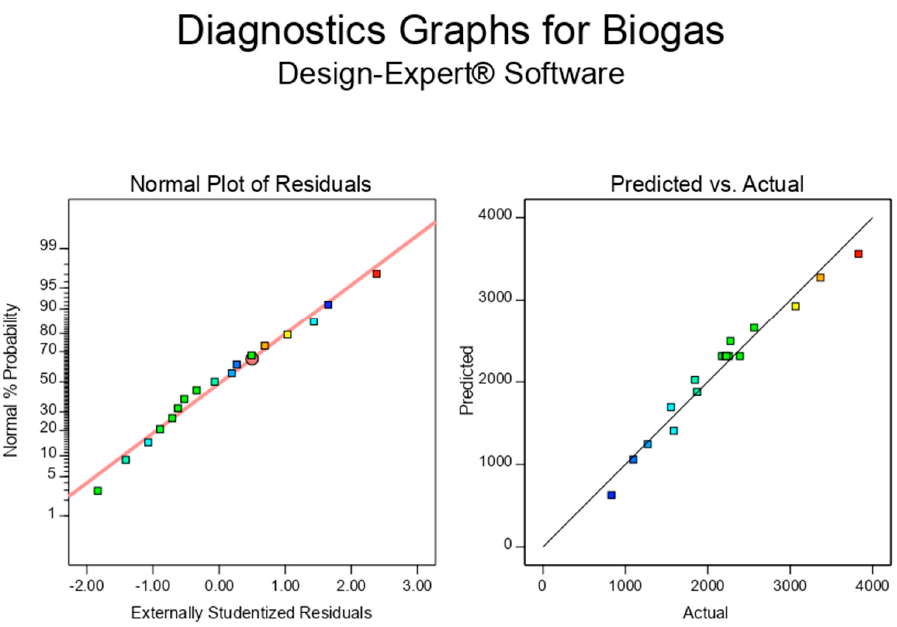
Figure 2. Normal probability and predicted vs. actual residual plots of biogas produced from CP.